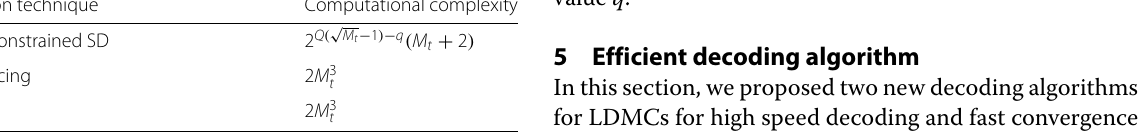
Table 1 Number of multiplications in LDMC-constrained SD, ZF, and MMSE detections Detection